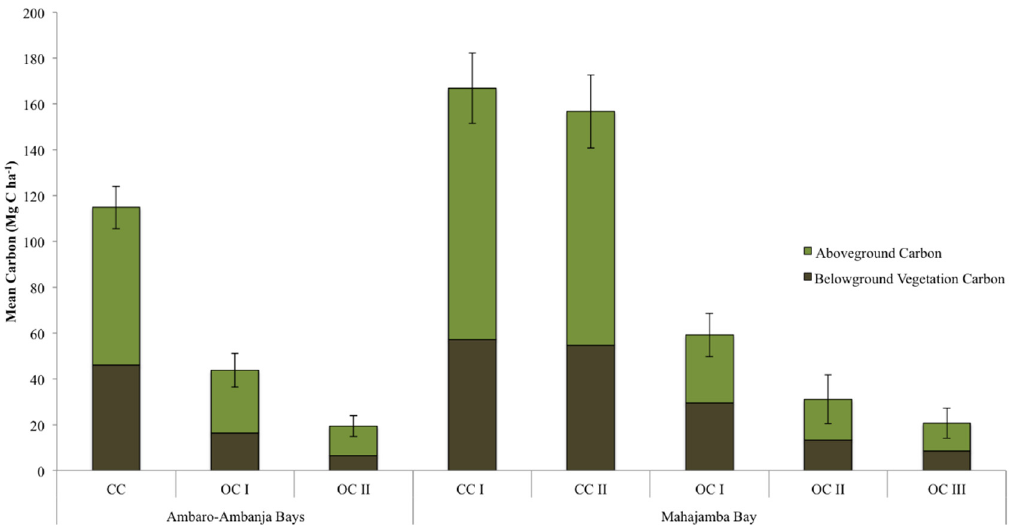
Figure 11. Above- and below-ground mangrove vegetation carbon estimates for the Ambaro-Ambanja Bays (AAB) [62] and Mahajamba Bay (MHJ) [61], Madagascar. Error bars represent ˘ SE of total vegetation carbon stocks. Adapted from Jones et al.